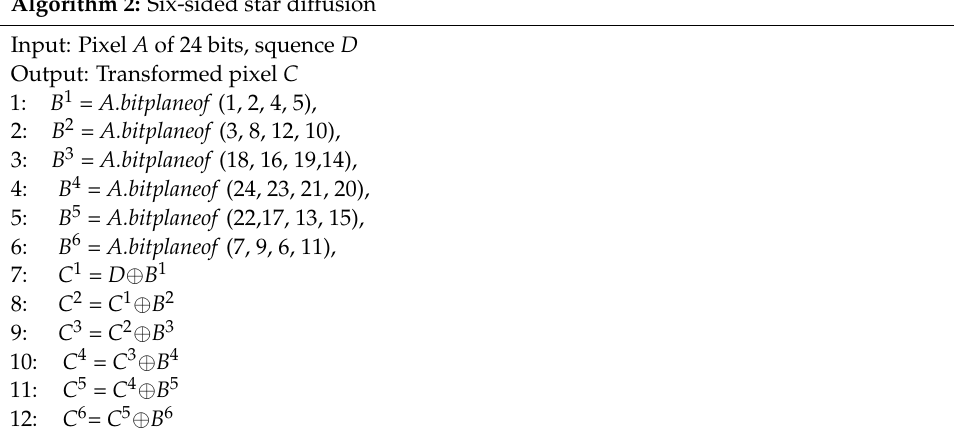
Algorithm 2: Six-sided star